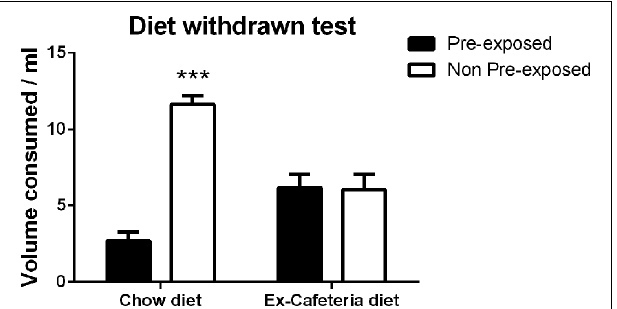
FIGURE 5 |Two bottle choice test of sensory-specific satiety following pre-exposure to palatable solutions in rats 1 week after withdrawal of the cafeteria diet ( N = 12) and chow fed control rats ( N = 12). Data presented as mean ( ± SEM). *** p < 0.001.Bonferroni